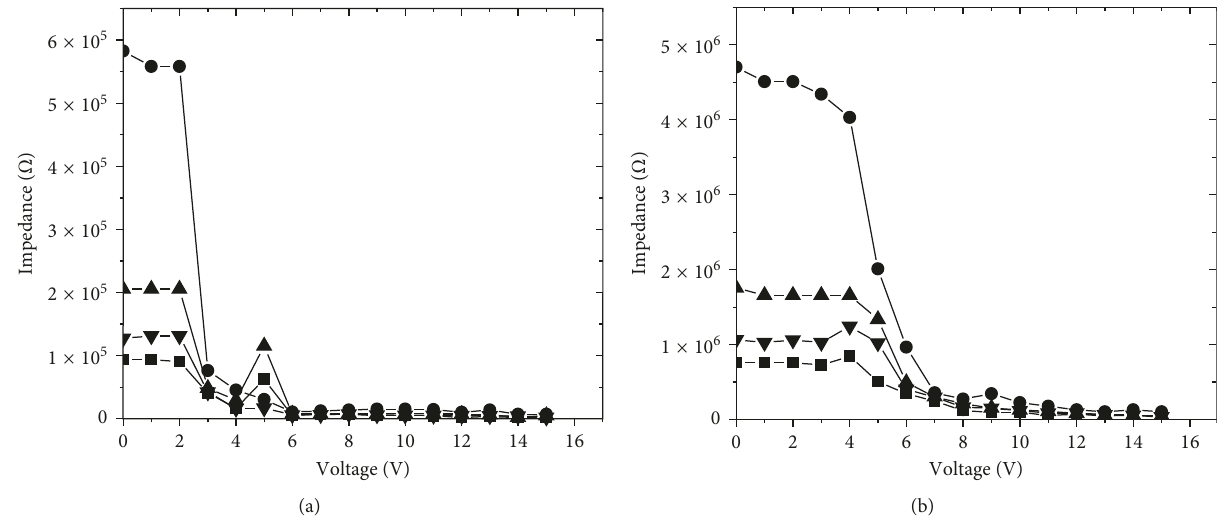
Figure 7: Impedance of the diode structure at different frequencies in the direct (a) and reverse (b) voltage ( • , 5kHz;